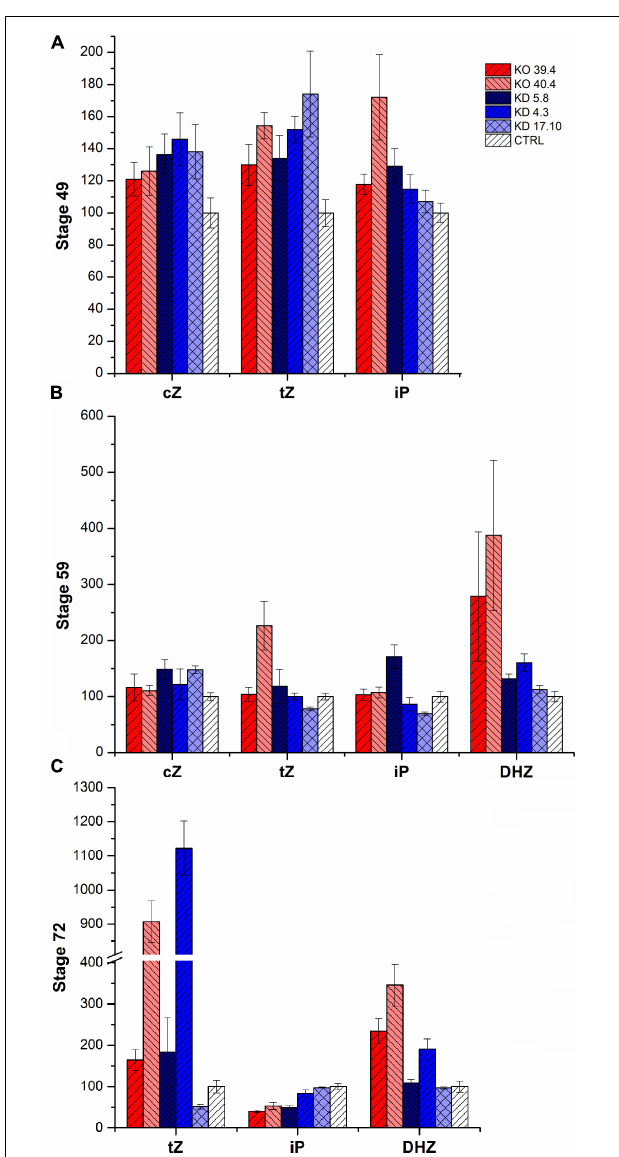
FIGURE 5 | Cytokinin content in the spikes of KD-CKX1 and KO-CKX1 mutant lines during three developmental stages of plants grown in the phytotron. Cytokinins were measured in stage 49 [booting: first awns visible (in awned forms only)] (A) , stage 59 (end of heading: inflorescence fully emerged) (B) and stage 71 (watery ripe: first grains have reached half their final size) (C) of three KD-CKX1 lines (5.8, 17.10, and 4.3) and two KO-CKX1 mutant lines (39.4 and 40.4). Data are expressed as percentage of the values obtained for the control plants (CTRL) that were set up to 100%. Values are means ± SE. cZ includes cZ free base, cZ riboside and cZ monophosphate; tZ includes tZ free base, tZ riboside, tZ monophosphate and tZ9 -glucoside; iP includes iP free base, iP riboside, iP monophosphate and iP9-glucoside; c Z, cis -zeatin; t Z, trans -zeatin; iP, isopentenyladenine; DHZ,